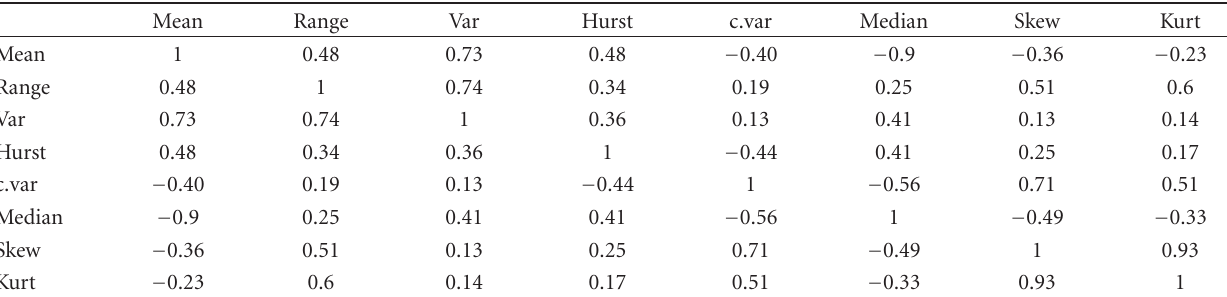
Table 3: Correlation between the selected variables.